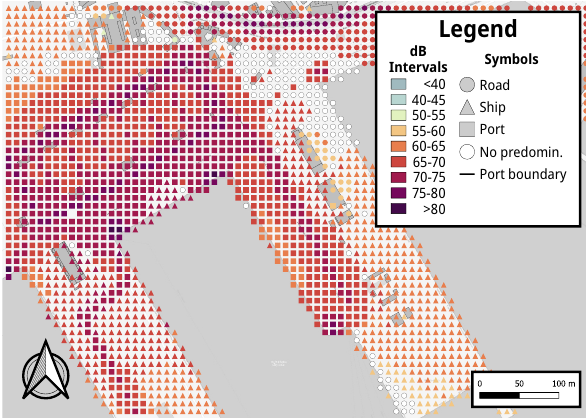
Figure 5: Detail of the I-NSP map of the port of Cagliari for L DEN